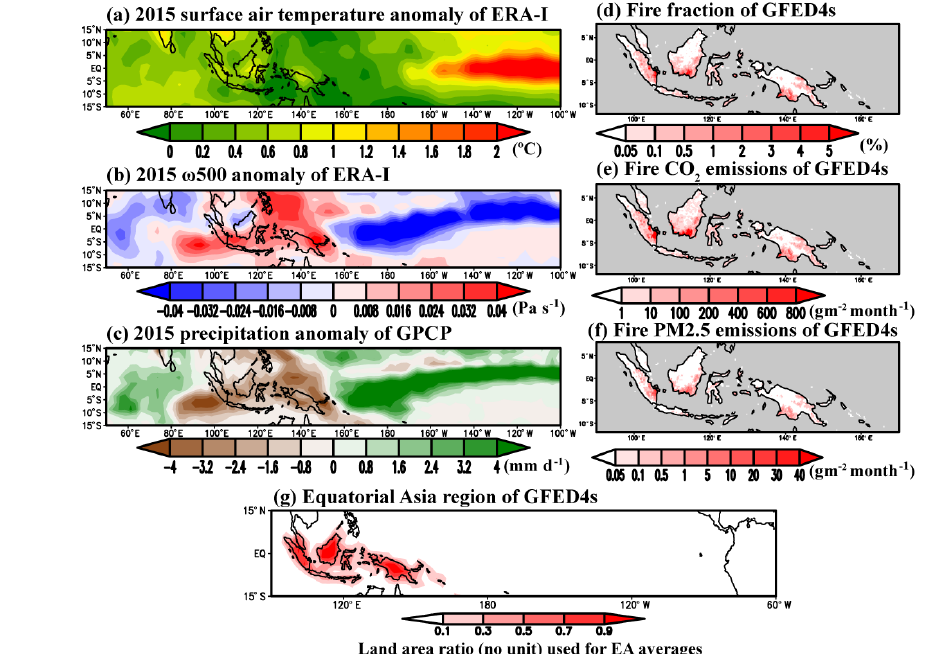
Figure 1. The observed climate conditions and fires. The June–November 2015 averaged anomalies of (a) surface air temperature ( ◦ C) and (b) vertical pressure velocity at the 500hPa level (Pas − 1 , downward motions are positive) from ERA Interim reanalysis data (Dee et al., 2011) relative to the 1979–2016 mean. (c) The June–November 2015 averaged anomalies of precipitation from GPCP (Adler et al., 2003) (mmd − 1 ). The right panels indicate (d) fire fraction (%), (e) fire CO 2 emissions (gm − 2 month − 1 ) and (f) fire PM 2 . 5 emissions from GFED4s (van der Werf et al., 2017) between June and November 2015. (g) The red area indicates the EA region of the GFED4s. We use this definition of the EA area. Shading shows the land area ratio (no unit) used for weighting in the computation of EA averages.